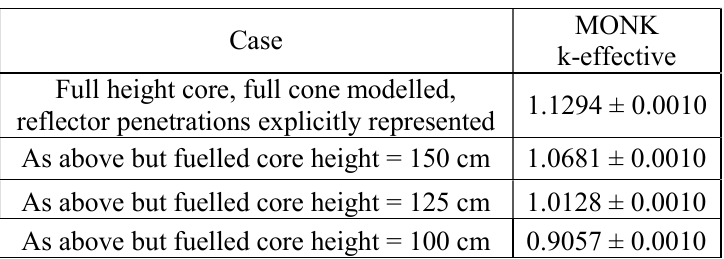
Table III. MONK Results for the HTR-10